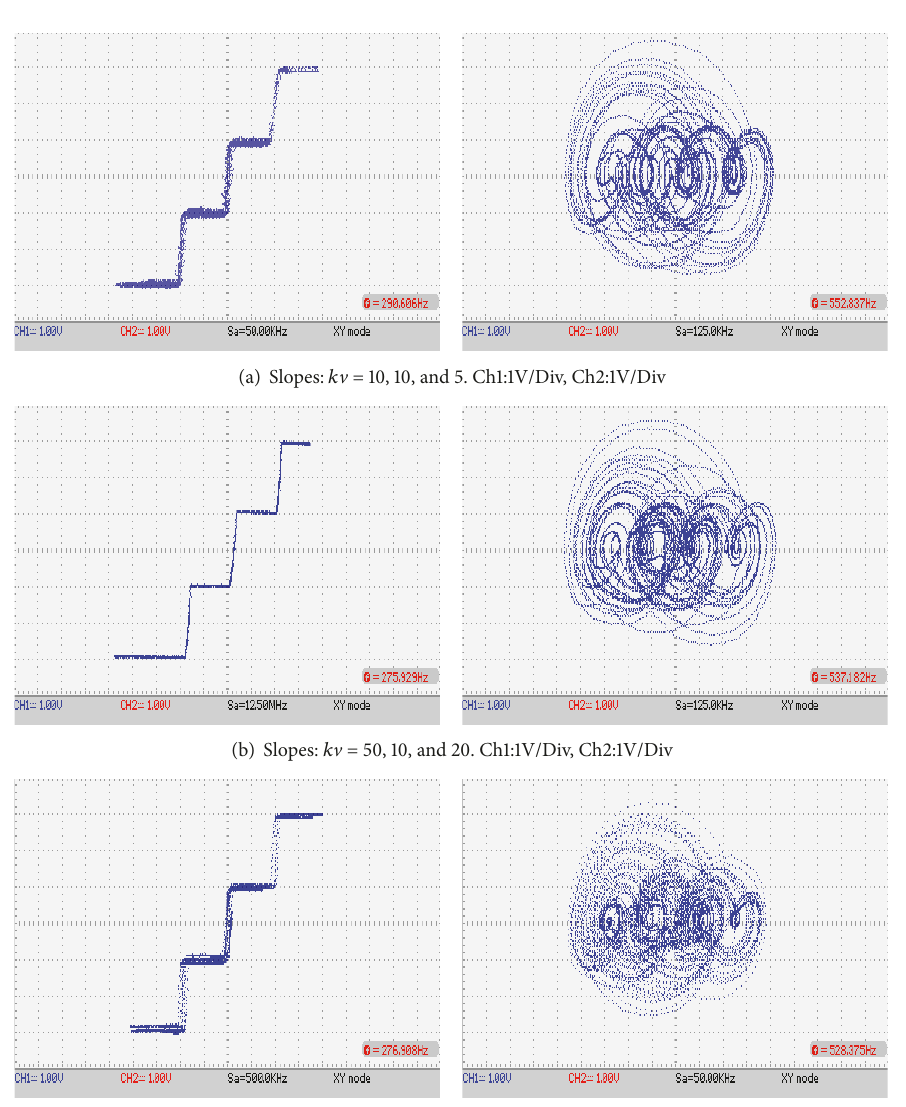
(c) Slopes: 𝑘 V = 30, 50, and 70. Ch1:1V/Div, Ch2:1V/Div Figure 7: Experimental verification of optimized 4 scrolls using irregular SNLFs with different slopes given in Table